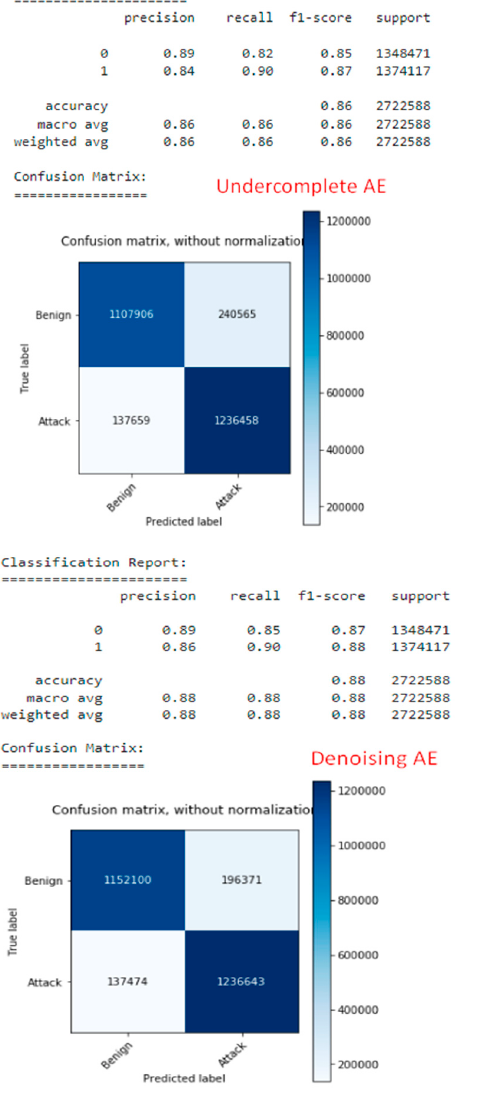
Figure 11. Performance of Undercomplete, Stacked, Denoising Autoencoders.